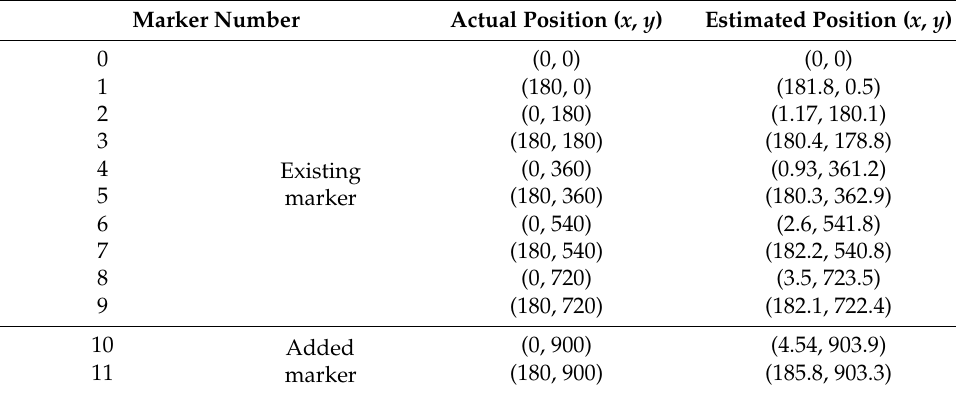
Table 6. Positions of existing and added